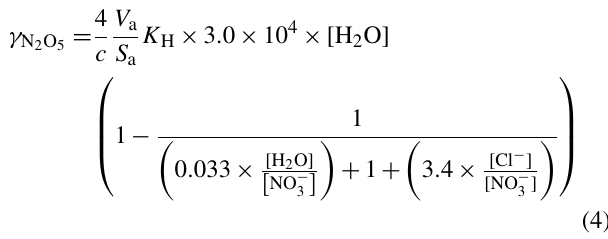
Figure 3. Summary of the comparisons of field-measured or de- rived γ N and values estimated from parameterizations from the 2 O 5 literature. Blue, orange, green, and red markers represent the results calculated from parameterizations of original BT09, BT09 exclud- ing chloride effect, BT09 plus organic effect, and BT09 excluding chloride but with organic effect, respectively.